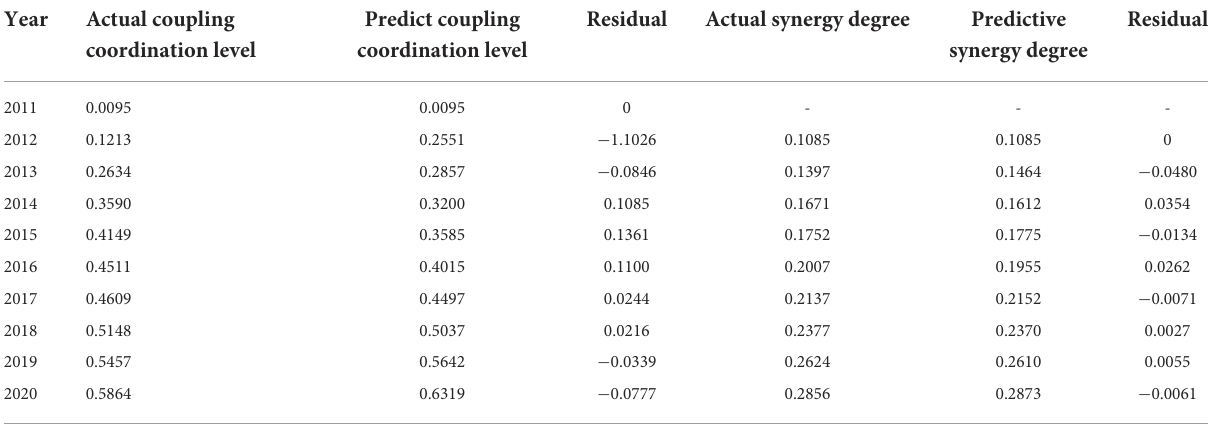
TABLE 11 Residual changes of coupling coordination level and synergy degree of low-carbon development in Anhui province from 2011 to 2020.